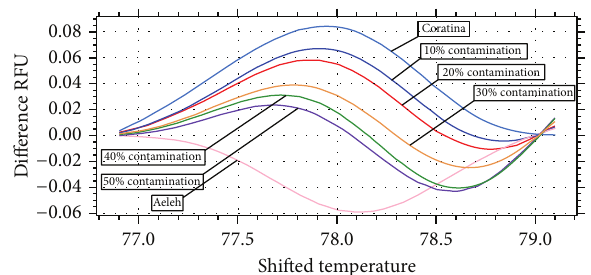
Figure 5: Temperature-shifted difference curve obtained with the addition of increasing quantity of cultivar Aeleh in Coratina mono- varietal